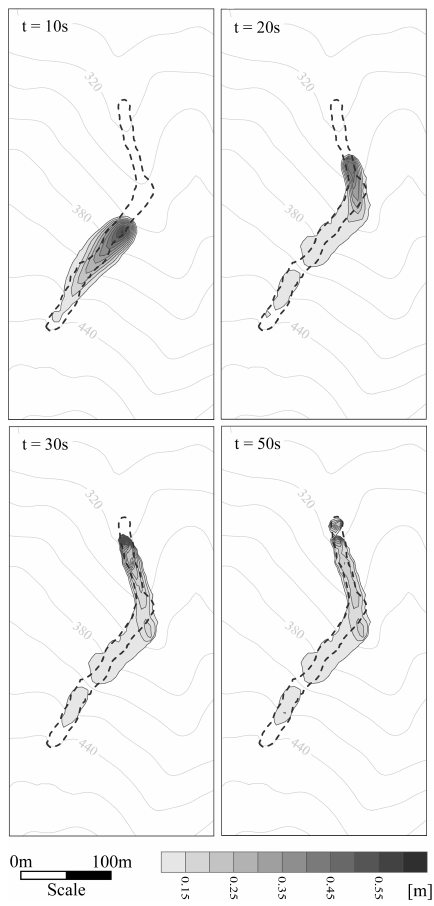
Fig. 6. The August 2005 debris flow – depth contours of sliding debris (Quadraticl rheology). The dotted line indicates the extent of the real event (propagation+deposit). Contours are at 0.05m